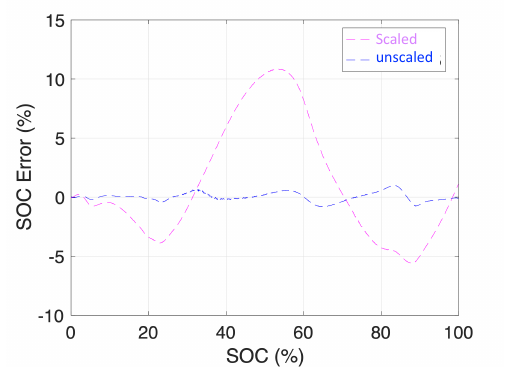
Figure 6. Scaling. The scaling approach [67] reduces the worst case error in OCV